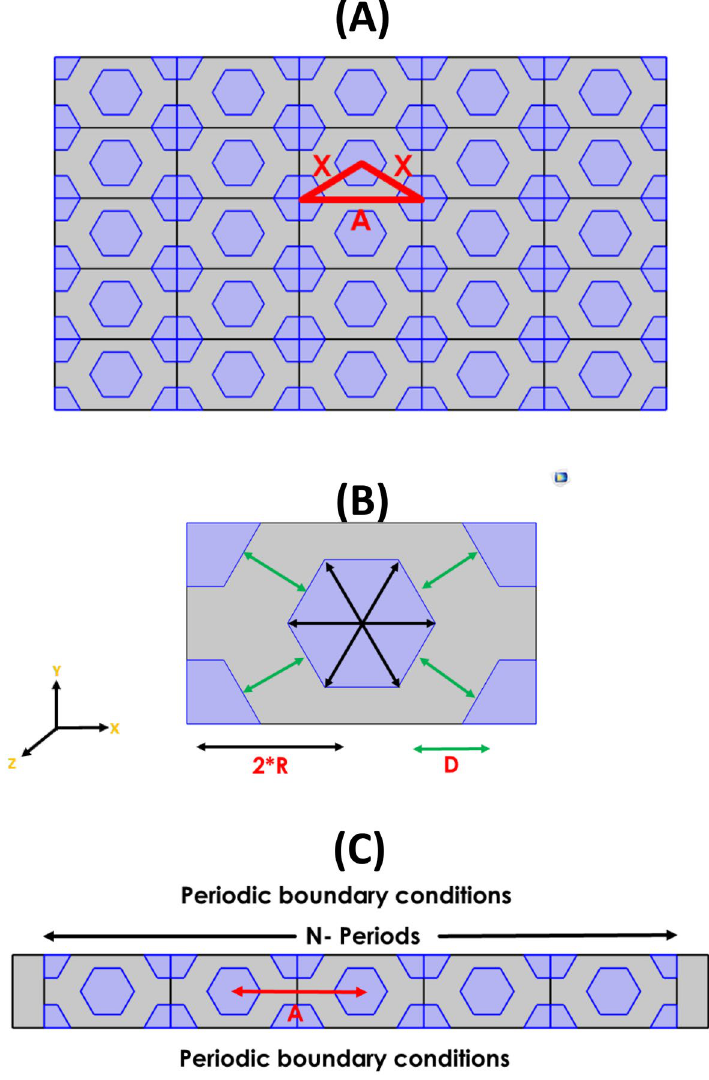
Figure 1. Schematic structure of 2D-PCs with hexagonal unit cell ( A ) surface of the structure with the distances between the hexagonal as shown, ( B ) one unit cell, and ( C ) the array of the unit cell in x